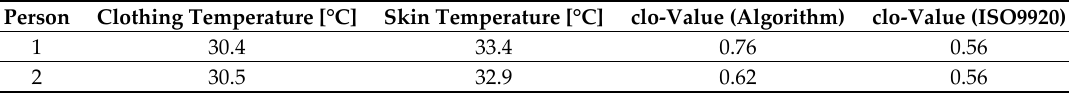
Table 1. Results of thermal imaging insulation